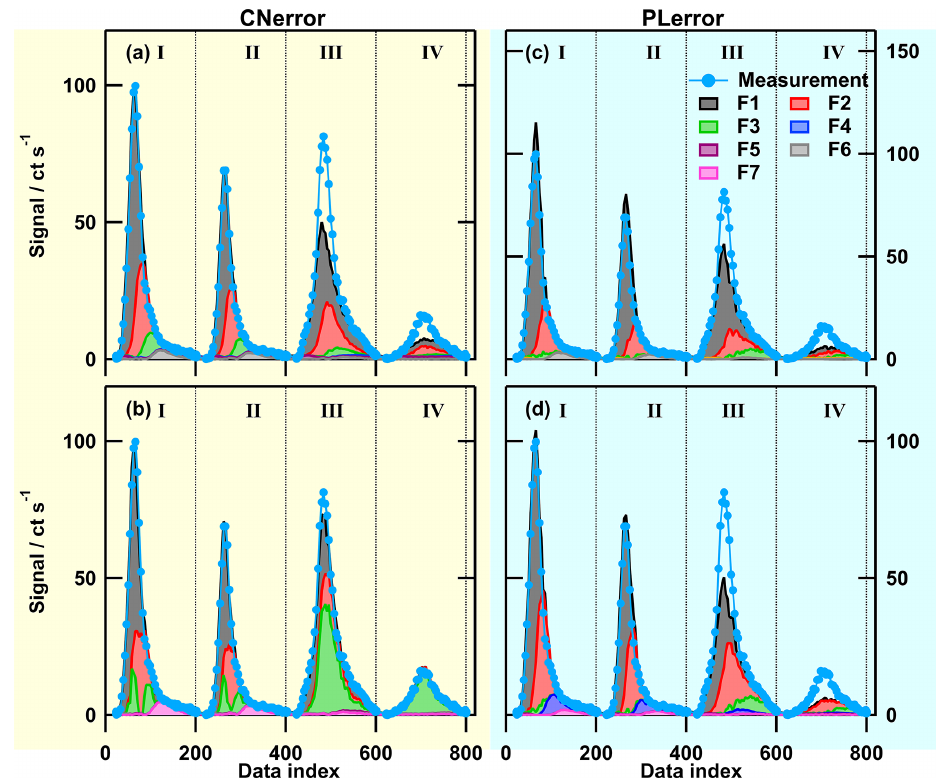
Figure A3. Combined single ion thermograms of the ion C 5 H 5 O − and PMF factor thermograms for 6- (a, c) and 7-factor (b, d) solutions. 6 Left column values (a, b) are calculated with CNerror and right column values (c, d) are calculated with PLerror. The data set contains thermogram scans for high-O : C SOA particles for the following sampling conditions: dry – t evap = 0 . 25h (I); dry – t evap = 4h (II); wet – t evap = 0 . 25h (III); and wet – t evap = 4h (IV). Note that generally the factors are not the same between the two error schemes or the two solutions (i.e. F1 in the 6-factor solution with CNerror is different to F1 in the 7-factor solution with CNerror,